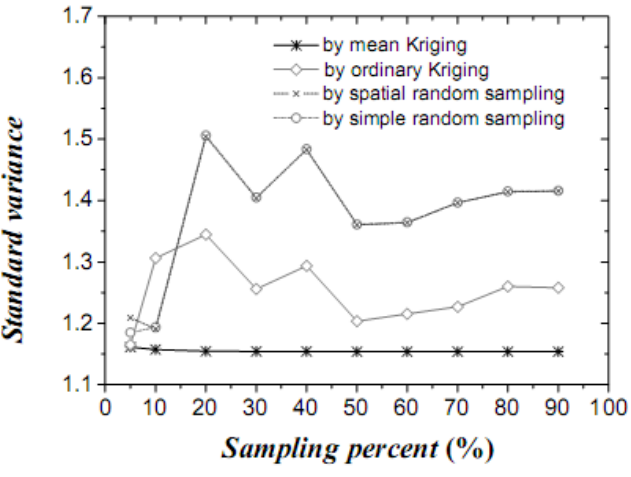
Figure 5. Standard variances of the estimated temperature (in o C) means by the three